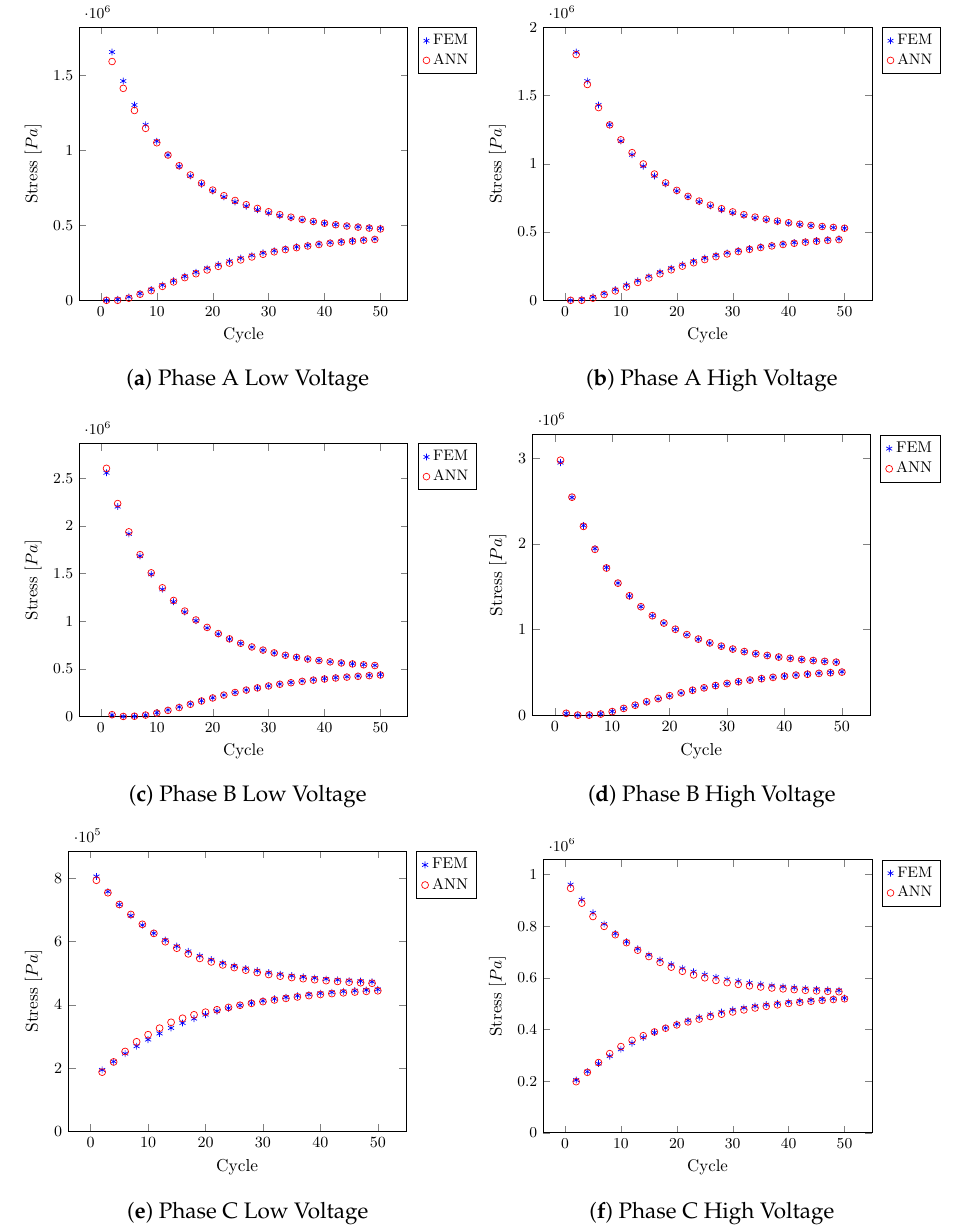
Figure 16. FEM and ANN simulations for a fault impedance of R = 1 Ω and X L = 47 Ω . Finally, a fault at the terminals of the transformer, with a resistance R = 1 Ω and X L = 15 Ω , is analyzed (see Figure 17). The transient ends in about 20 cycles. The highest stress is present in Phase A, which agrees with the fault time when Phase A crosses zero. Most of the results are very close for FEM and ANN. A few cases where an appreciable difference exists are located at the beginning of the transient in Phase B and Phase C, for the highest stress